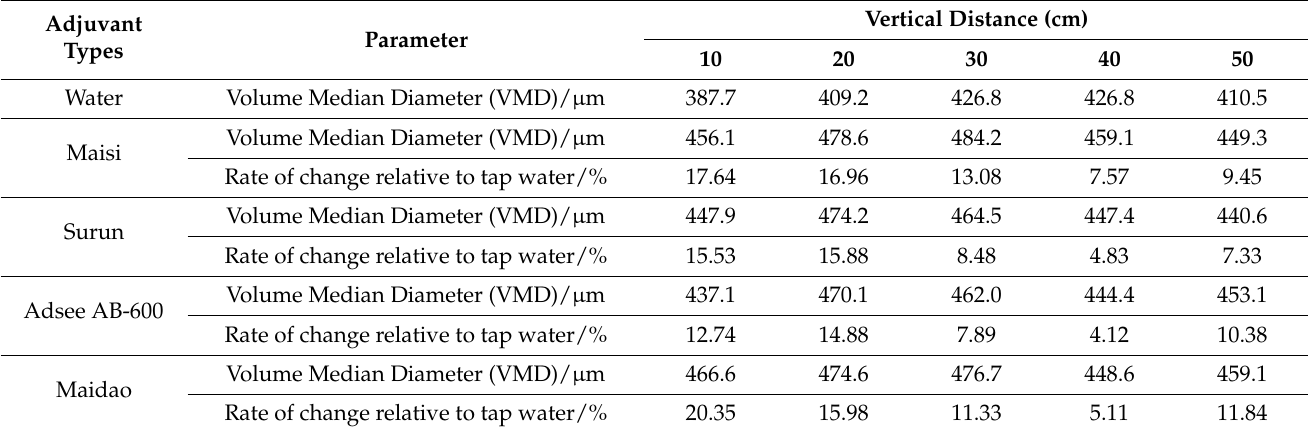
Table 4. Droplet size distribution at different